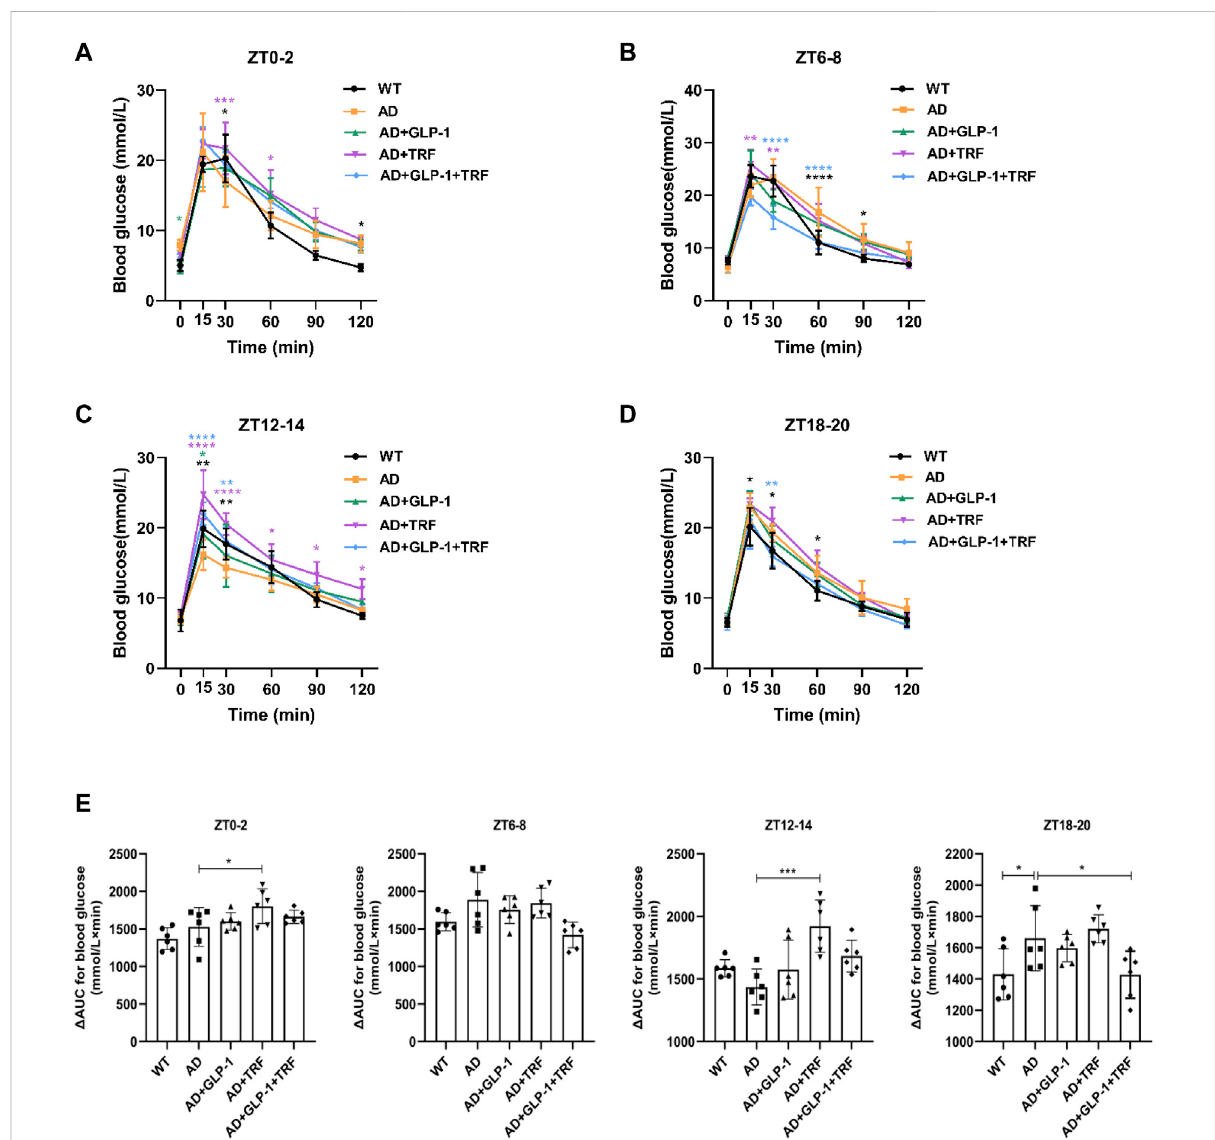
FIGURE 4 Effect of GLP-1and TRF on glucose metabolism. (A – D) Individual responses in blood glucose to identical intraperitoneal glucose tolerance test (IPGTT) conducted at four time points throughout the day ( n = 6 per time point and per group). * p < 0.05, ** p < 0.01, *** p < 0.001, **** p < 0.0001 compared to the AD group using two-way ANOVA followed by Dunnett ’ s test. (E) Corresponding Δ AUC for blood glucose. n = 6, * p < 0.05, *** p < 0.001 vs. AD group using One-Way ANOVA followed by Dunnett ’ s